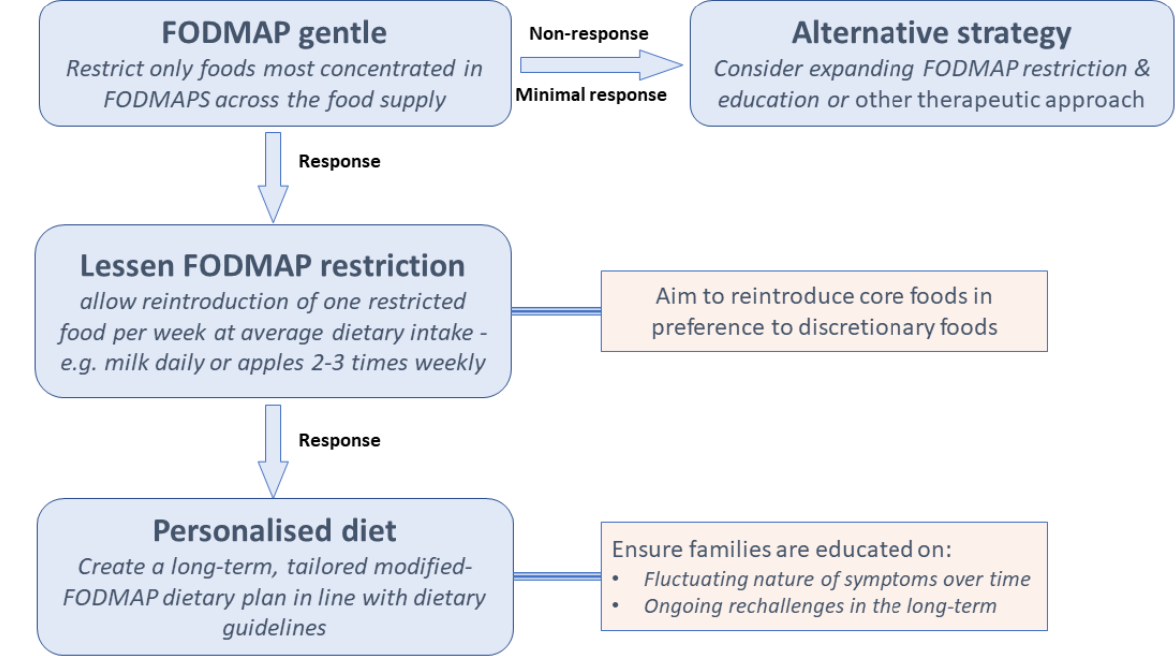
Figure 1. FODMAP gentle proposed framework as it applies to children.